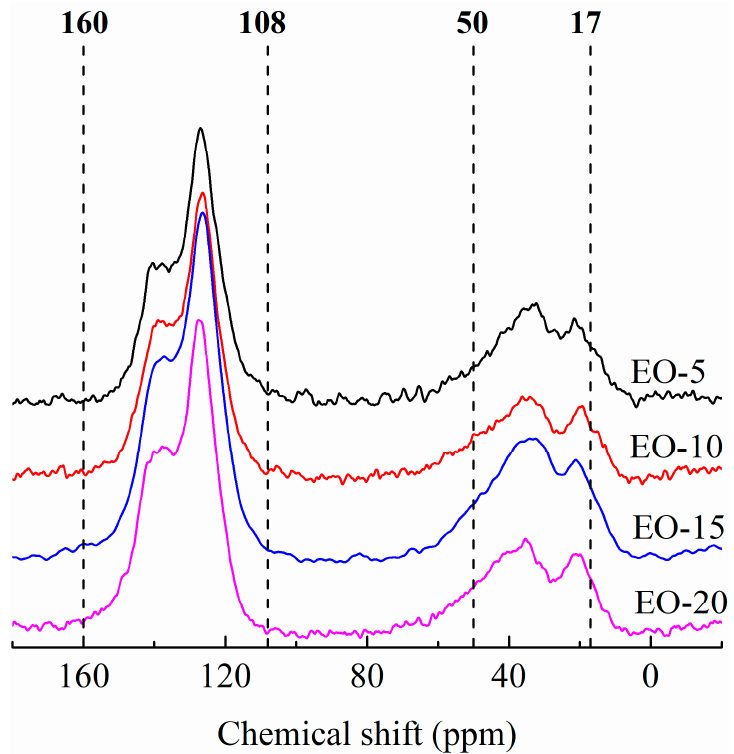
Figure 6. 13 C NMR spectra of isotropic pitch precursors.